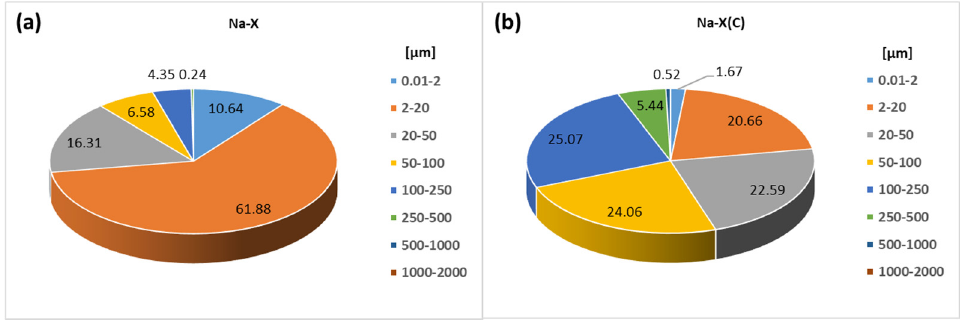
Figure 1. Particle size distribution ( v/v %) of ( a ) Na-X and ( b ) Na-X(C) materials.